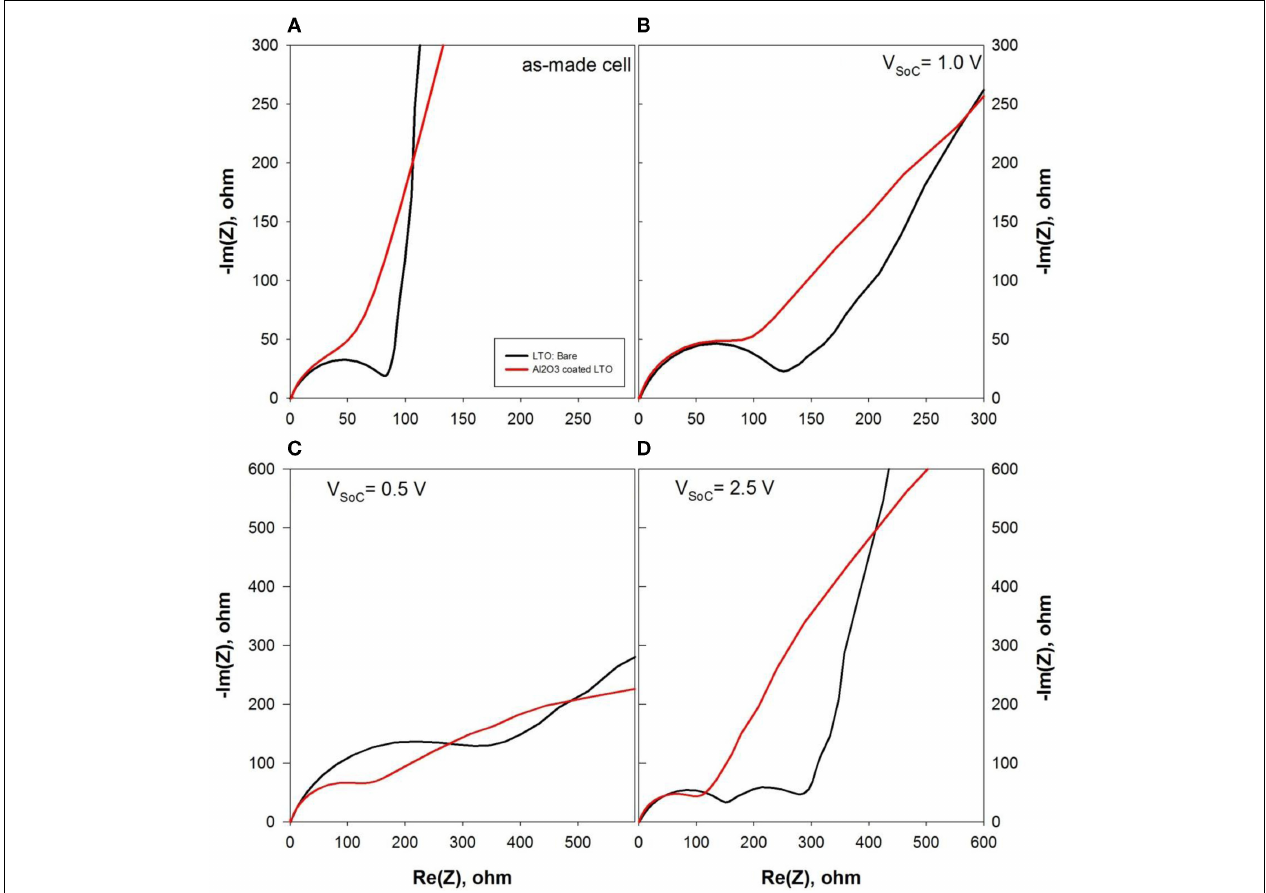
FIGURE 7 | Electrochemical impedance spectroscopy (EIS) analysis of LTO (black line) and Al 2 O 3 -coated LTO (red line): (A) as-made, (B) discharged to 1.0V, (C) discharged to 0.5V and (D) charged to 2.5V vs. Li/Li + .